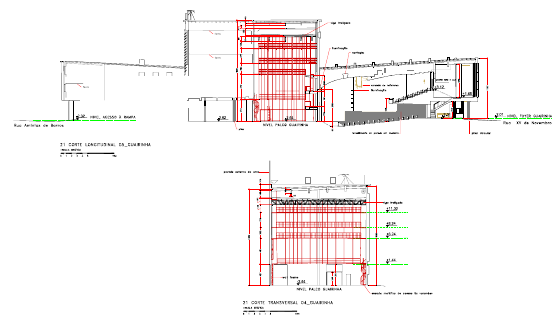
Figure 4. Small Auditorium “Guairinha” - Longitudinal and Transversal Sections